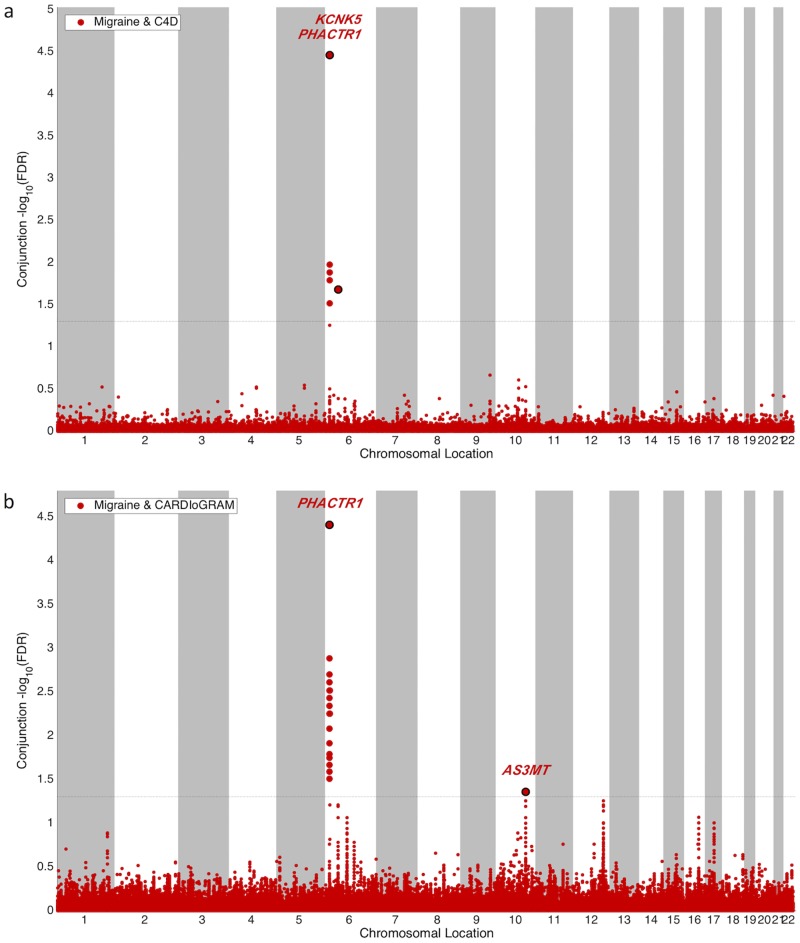
Conjunction FDR Manhattan plots—Shared risk loci between migraine and coronary artery disease (CAD).SNPs with conjunctional false discovery rate (FDR) < 0.05 are shown with large points. A black line around the large points indicate the most significant SNP in each linkage disequilibrium block, annotated with the closest gene. Separate plots are shown for cross-phenotype loci between a) migraine and C4D, and b) migraine and CARDIoGRAM.